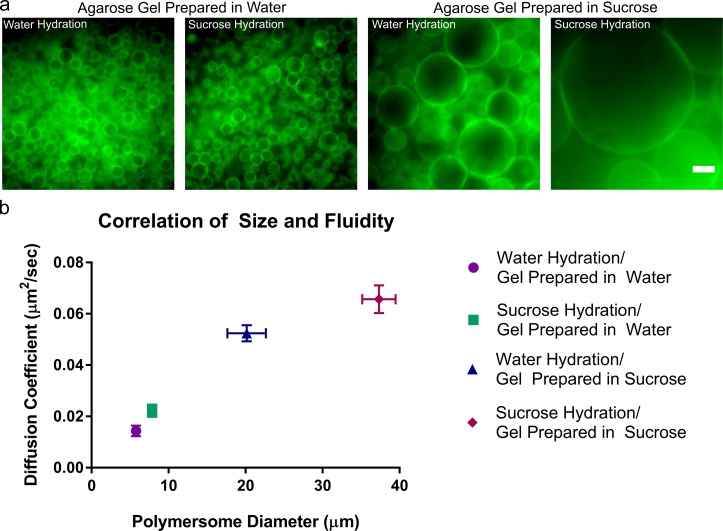
Effects of membrane fluidization on the formation of polymersomes.(a) Epifluorescence photomicrographs of PEO-PBD polymersomes formed on either agarose gels in water (left two images) or agarose gels in sucrose (right two images) and rehydrated in either water or sucrose as indicated at the top of the image. Scale bar = 10 μm. (b) Correlation of polymersome size (measured for over 80 polymersomes) and diffusion coefficients (calculated for at least five different polymersomes). X-error bars are standard error of the mean for the polymersome diameters. Y-error bars are standard error of the mean for the diffusion coefficients.